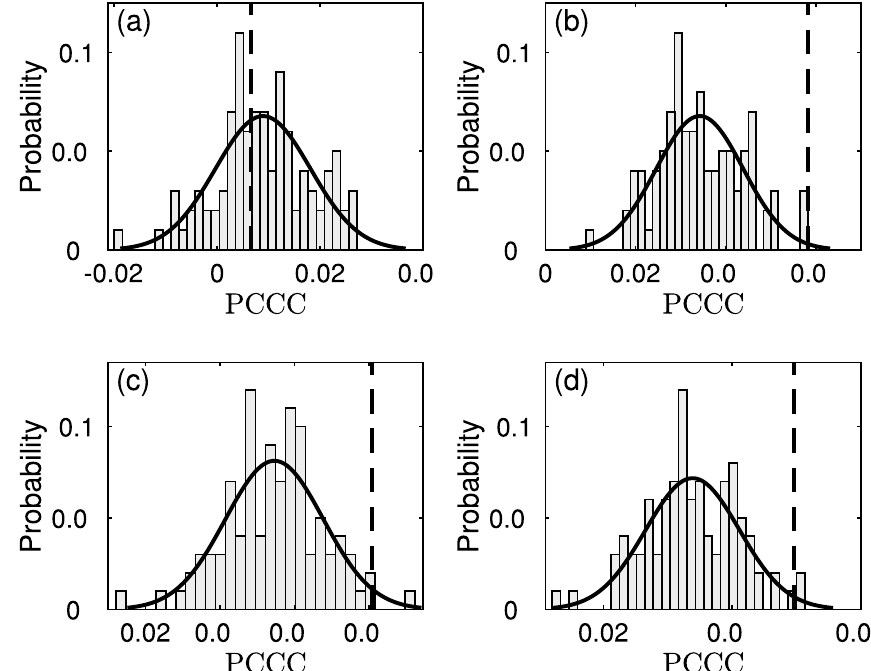
Figure 3. PCCC surrogate analysis results. PCCC surrogate analysis results for: ( a ) Kilo-year scale CO 2 → T, ( b ) Kilo-year scale T → CO 2 , ( c ) Yearly ENSO → SASM, ( d ) SASM → ENSO. Dashed line indicates PCCC value obtained for original series. Its position is indicated with respect to Gaussian curve fitted normalized histogram of surrogate PCCC values. PCCC for cases ( b )–( d ) is found to be significant.